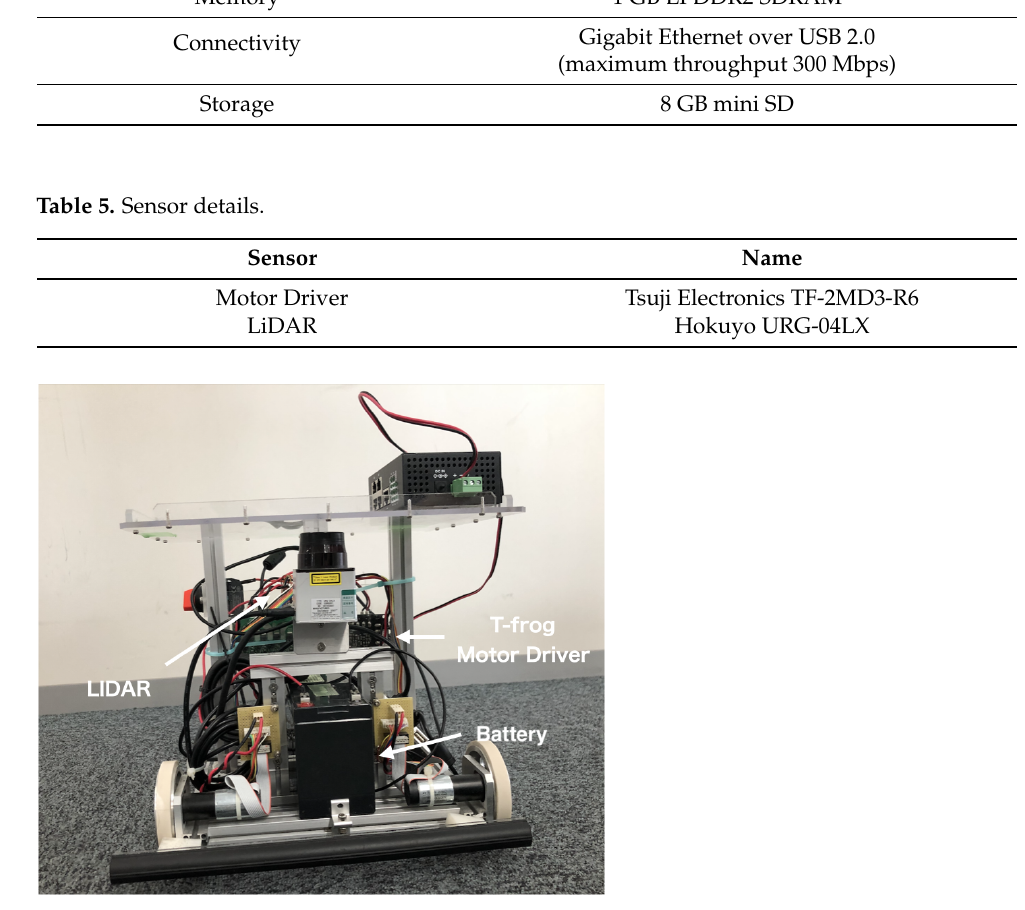
Figure 6. The shape of our unmanned vehicle robot and equipped